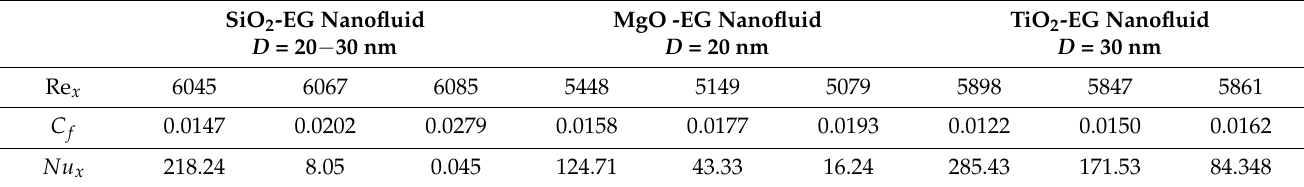
Table 6. The values of C f and Nu x at different values of Re x at fixed x =